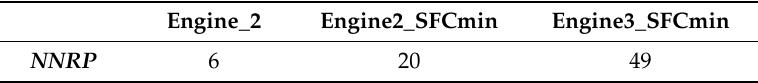
Table 11. Number of non-revenue